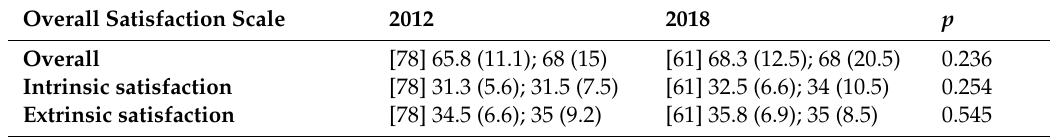
Table 3. Comparison of the scores of the overall satisfaction scale of the years 2012 and 2018.